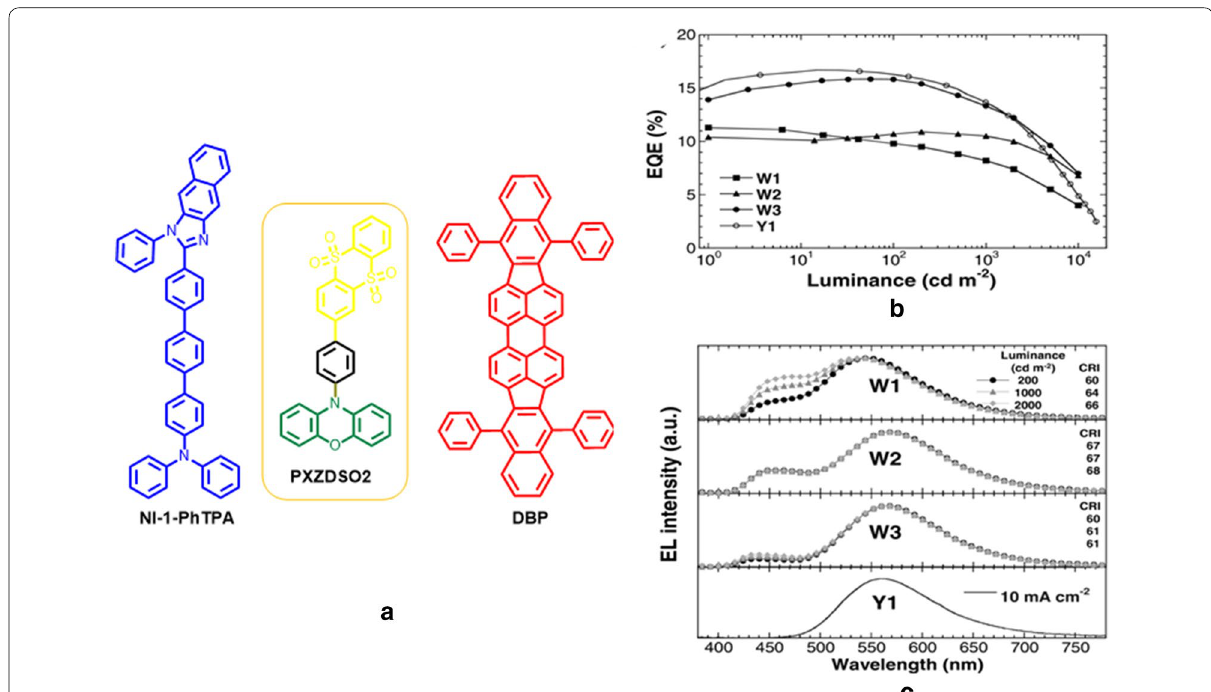
Fig. 16 a Chemical structure of NI-1-PhTPA, PXZDSO2 and DBP, b EQE vs. luminance spectra and c EL spectra of the OLEDs W1, W2, W3, and Y1